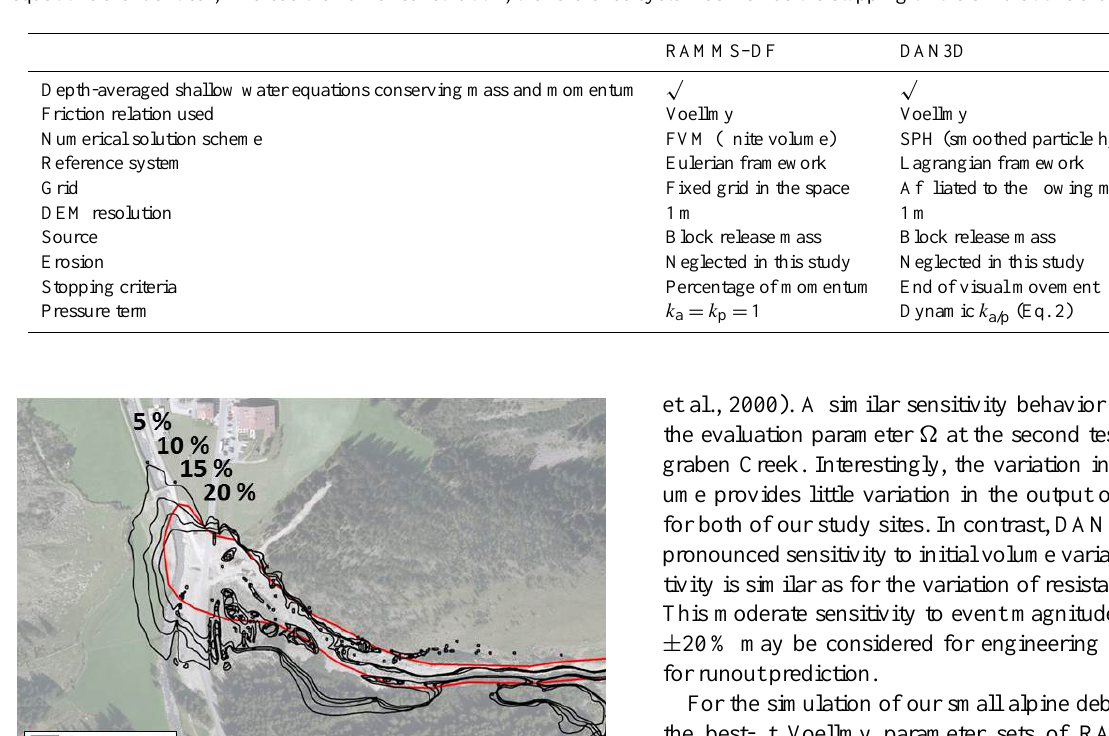
Table 1. Comparison of model input conditions within our study. Grids, triggering conditions, excluded erosion, rheology and the governing equations are identical, whereas the numerical solution, the reference system as well as the stopping of the simulations are different.